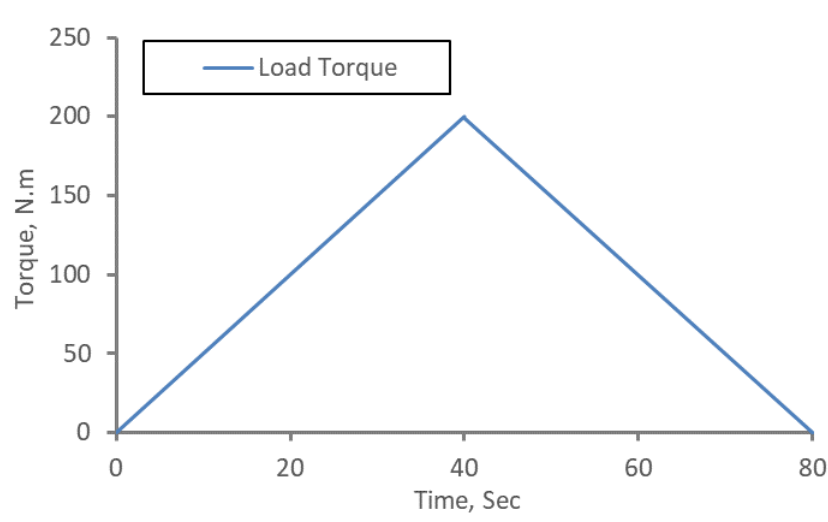
Figure 9. -Ramp input for engine speed controller.